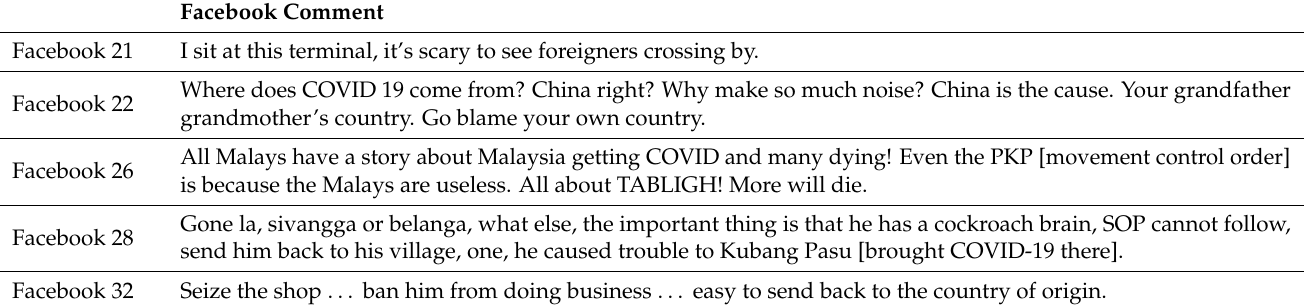
Table 2. Examples of ethnicity-related stigmatization of COVID-19 patients in Facebook comments (N =